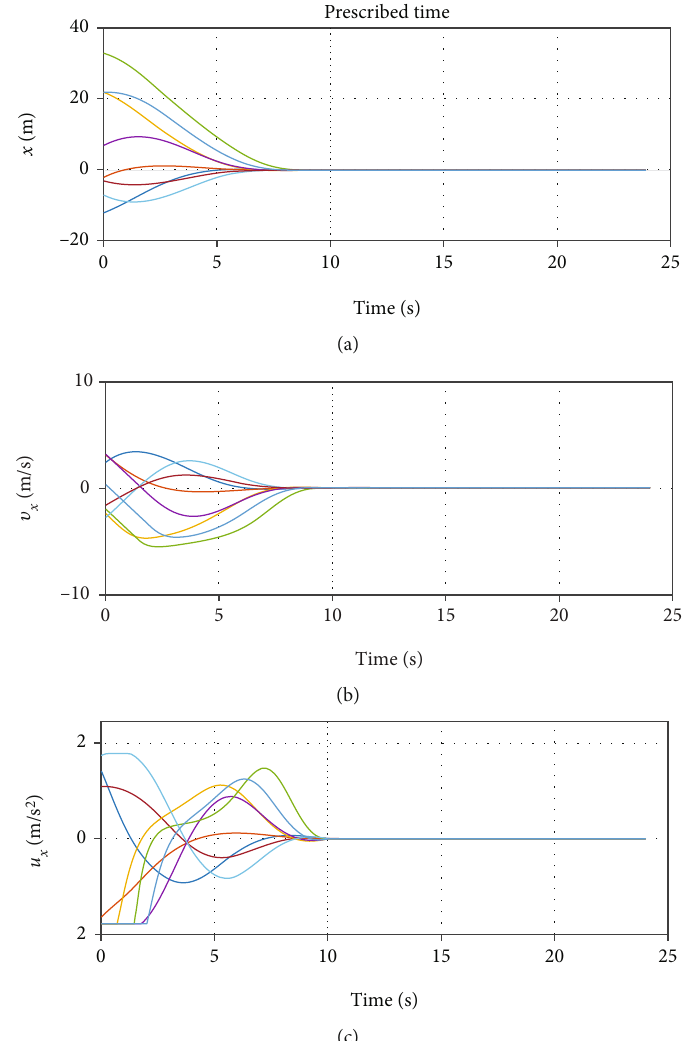
Figure 8: The x -axis (a) position error, (b) velocity error, and (c) control input curves of the proposed controller with the prescribed time = 10s t f